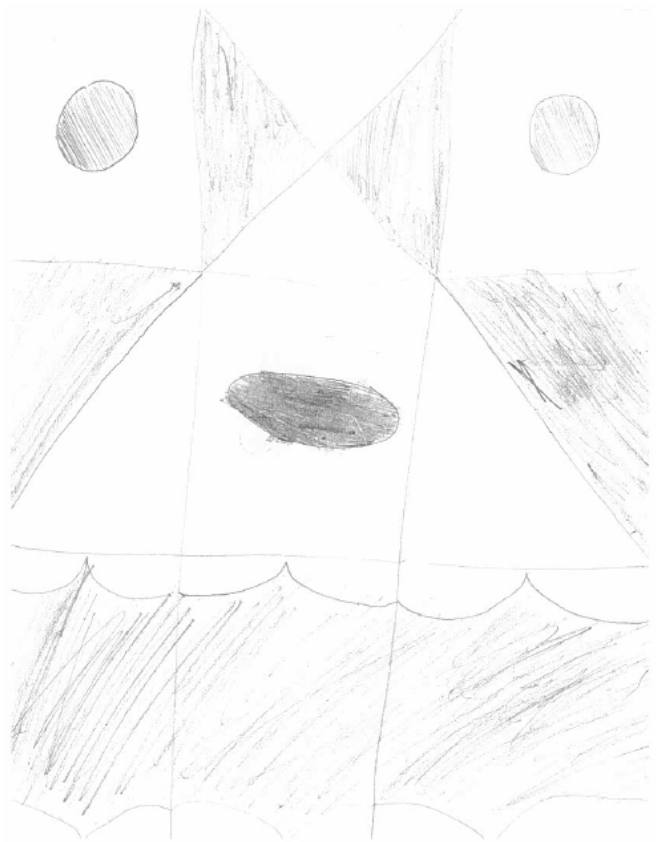
Figure 5. Group 4’s created